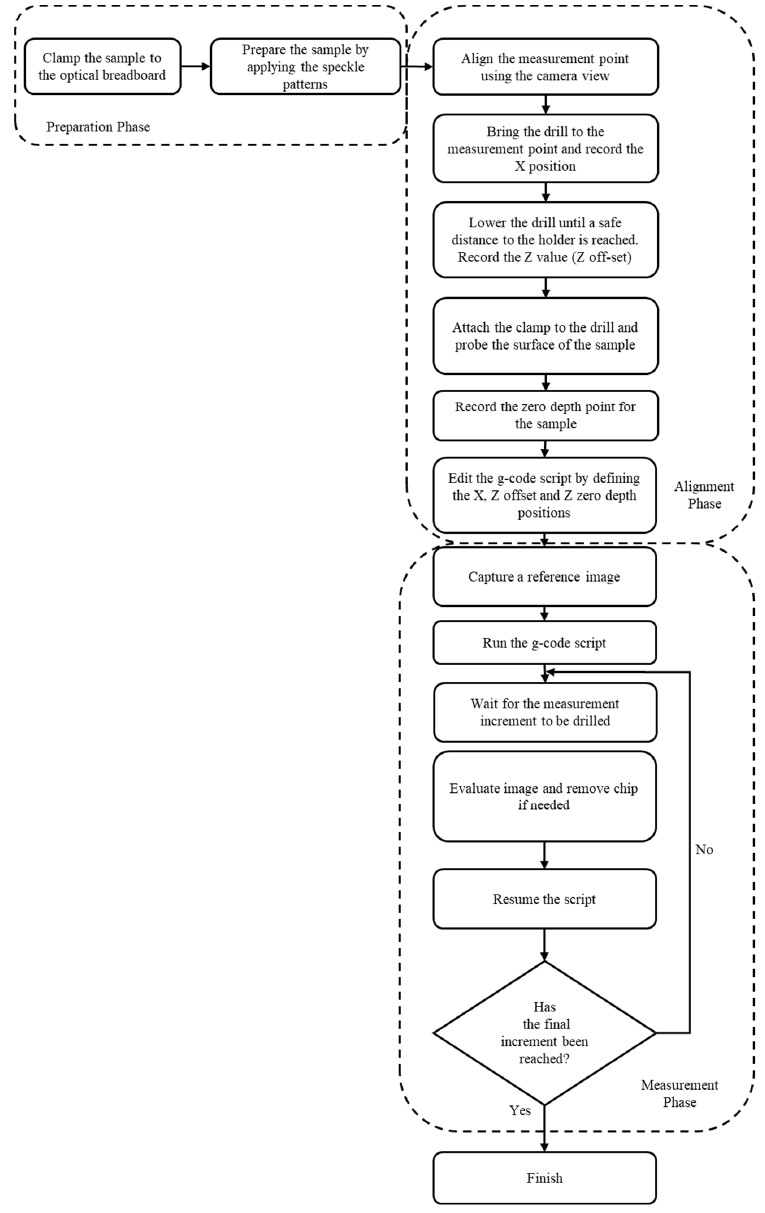
Figure 3. Operating principles of the measurement device.